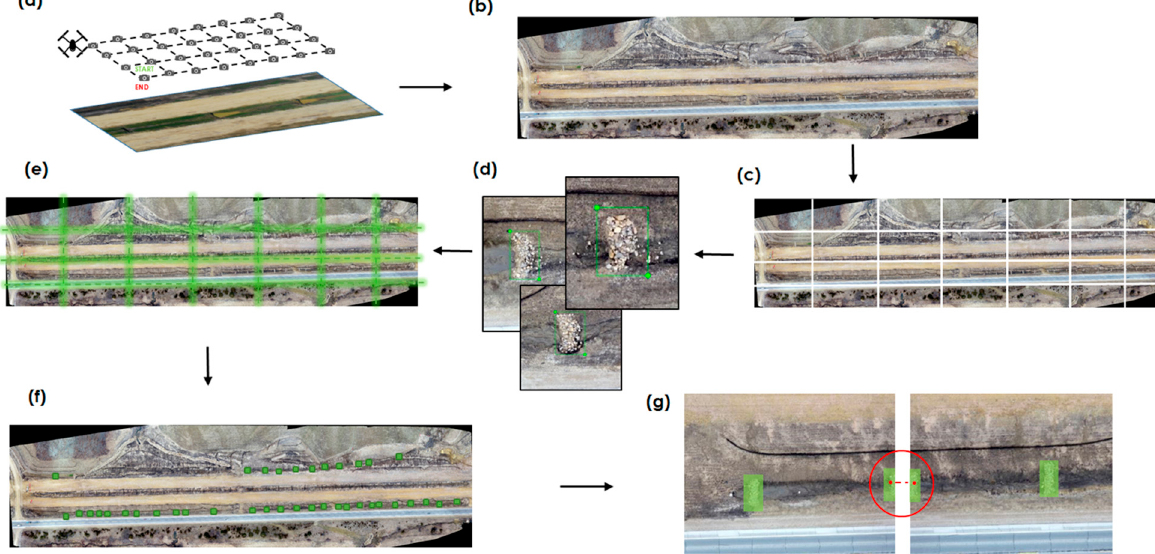
Figure 5. Detection flow chart: ( a ) aerial image capturing; ( b ) mosaic view layout preparation; ( c ) image tiling; ( d ) annota- tions; ( e ) image merging; ( f ) preliminary detection; ( g ) post-processing.